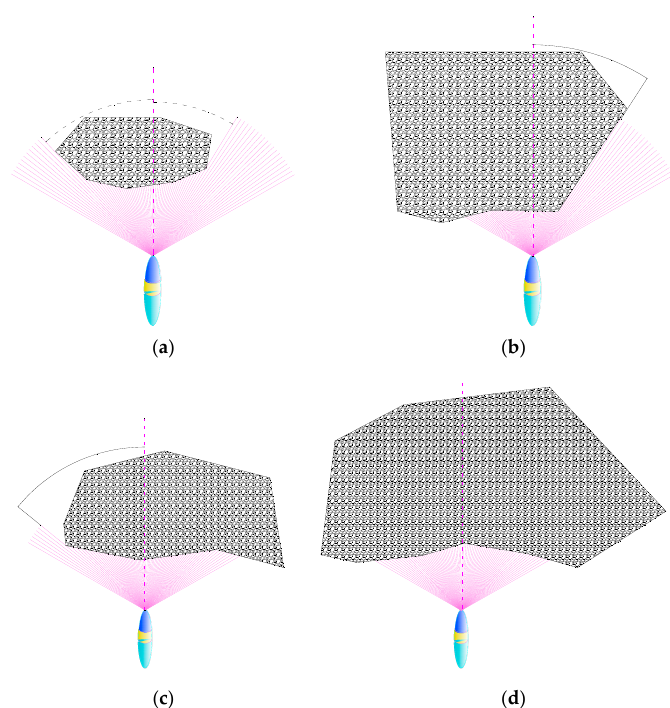
Figure 4. Obstacle classification. ( a ) bounded obstacle; ( b ) left unbounded obstacle; ( c ) right unbounded obstacle; ( d ) unbounded obstacle.